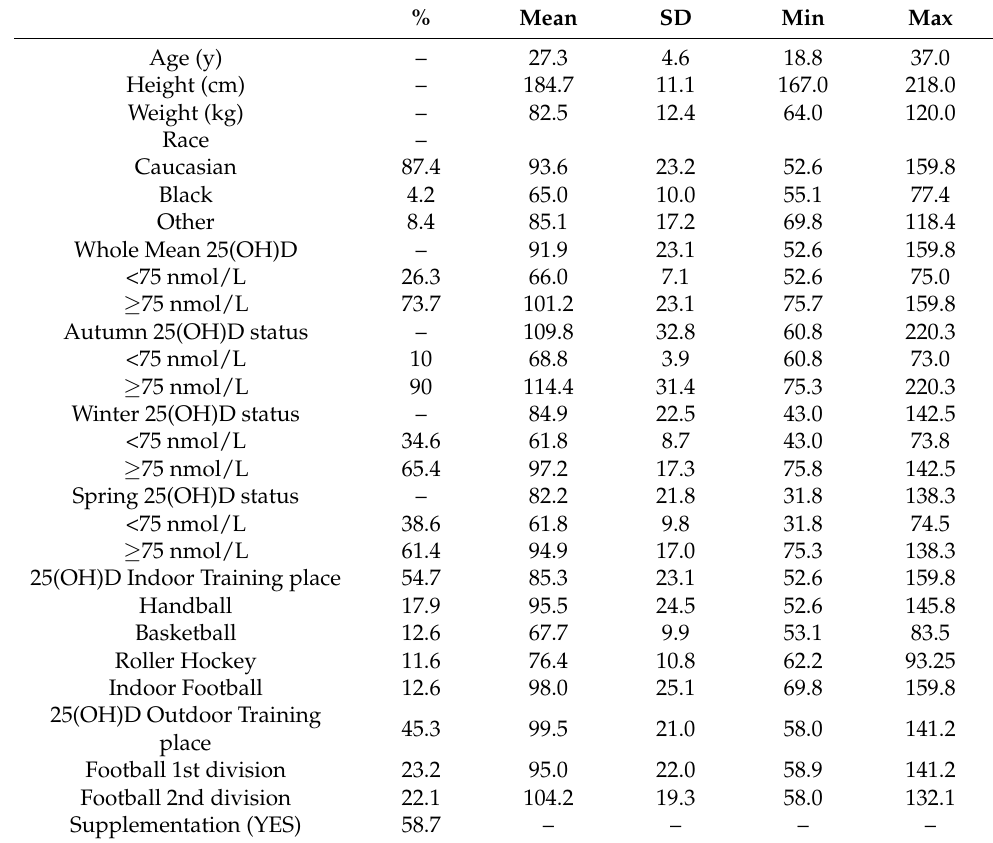
Table 1. Descriptive characteristics of the sample. Vitamin D concentrations (nmol/L) according to sufficient–insufficient cut-off points and training place for the total